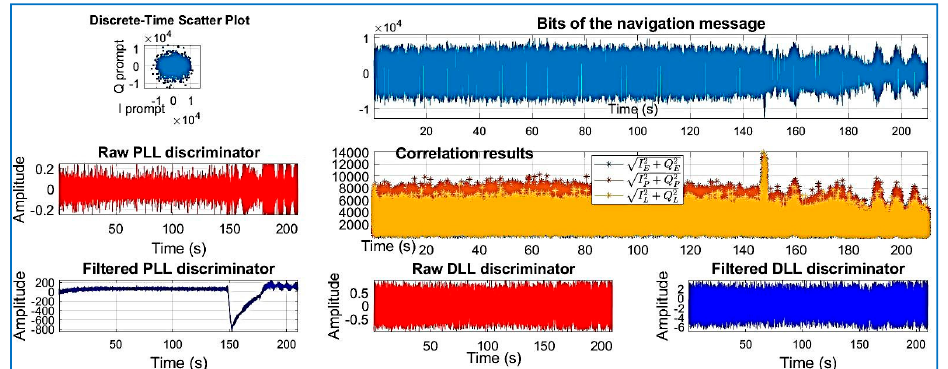
Figure 21. PRN 14, channel 04, Dataset 3.